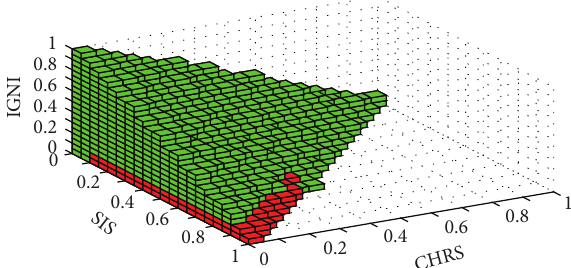
Figure 12: Cluster representation of the failure domain (red) and safety domain (green) for the sequence [ INI SIS CHRS IGNI ] . Axes scaled between 0 and 1.